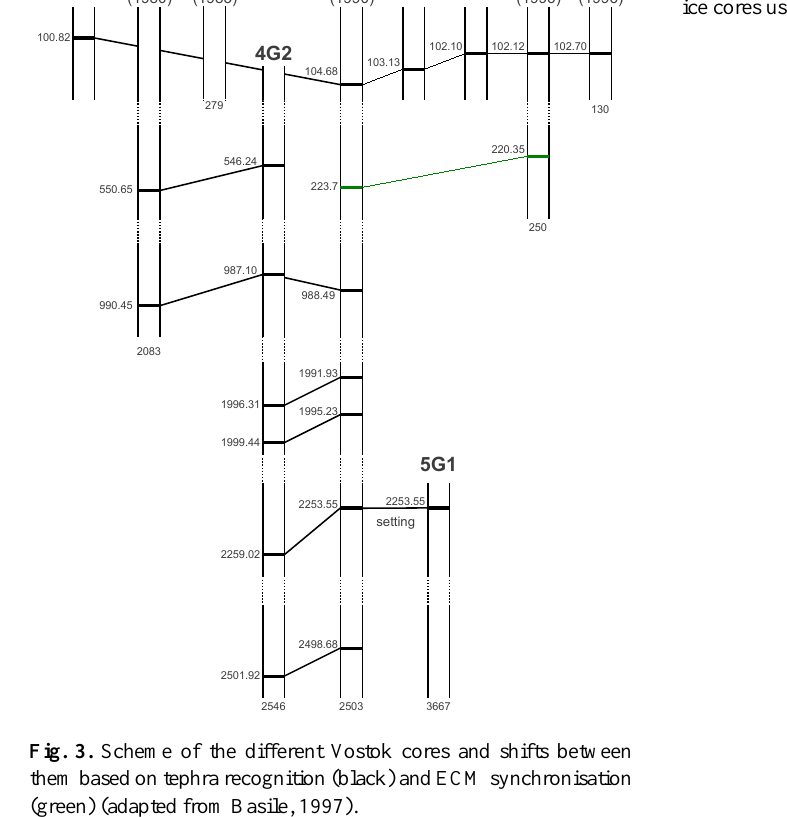
Table 1. List of volcanic tie points between the EDC96 and EDC99 ice cores using the DEP